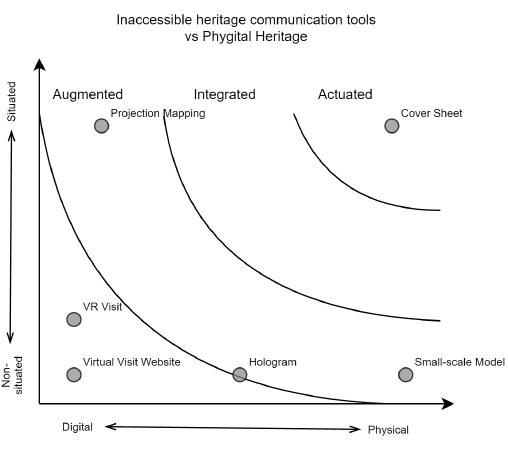
Figure 8 . Inaccessible heritage communication tools in regard to the Phygital Heritage model.